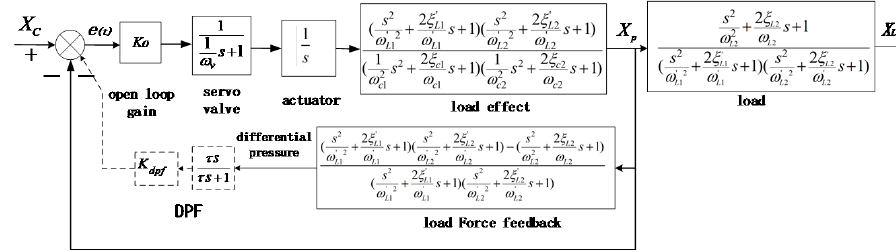
9 of 18 Figure 12. The combined control strategy. The control algorithm comprises three parts: a notch filter network, a nonlinear PID and a feedforward compensation. A baseline two-notch-filter network G n is shown as Equation (20). 𝐺 (cid:3041) = 1 𝜔 (cid:3041)(cid:2869)(cid:2870) 𝑠 (cid:2870) + 2𝜉 (cid:3041)(cid:2869) 𝜔 (cid:3041)(cid:2869) 𝑠 + 1 1 𝜔 (cid:3031)(cid:2869)(cid:2870) 𝑠 (cid:2870) + 2𝜉 (cid:3031)(cid:2869) 𝜔 (cid:3031)(cid:2869) 𝑠 + 1 . 1 𝜔 (cid:3041)(cid:2870)(cid:2870) 𝑠 (cid:2870) + 2𝜉 (cid:3041)(cid:2870) 𝜔 (cid:3041)(cid:2870) 𝑠 + 1 1 𝜔 (cid:3031)(cid:2870)(cid:2870) 𝑠 (cid:2870) + 2𝜉 (cid:3031)(cid:2870) 𝜔 (cid:3031)(cid:2870) 𝑠 + 1 (20) The rationale is that the poorly damped poles ( ω c 1 , ξ c 1 ) and ( ω c 2 , ξ c 2 ) are cancelled out by a pair of nearby poorly damped zeros ( ω n 1 , ξ n 1 ) and ( ω n 2 , ξ n 2 ) and replaced with a pair of better damped poles ( ω d 1 , ξ d 1 ) and ( ω d 2 , ξ d 2 ). In aerospace applications, the structural quality is guaranteed so that the resonance frequencies are controlled well within toler- ances and notch filters can be applied in faith. On the other hand, the parameters can be optimized to change the width and depth of the notch window to accommodate permitted model variations, even to control a three resonance peak model as later shown. For non- stationary natural frequencies, Yao J. recommended adaptive notch filters [16].